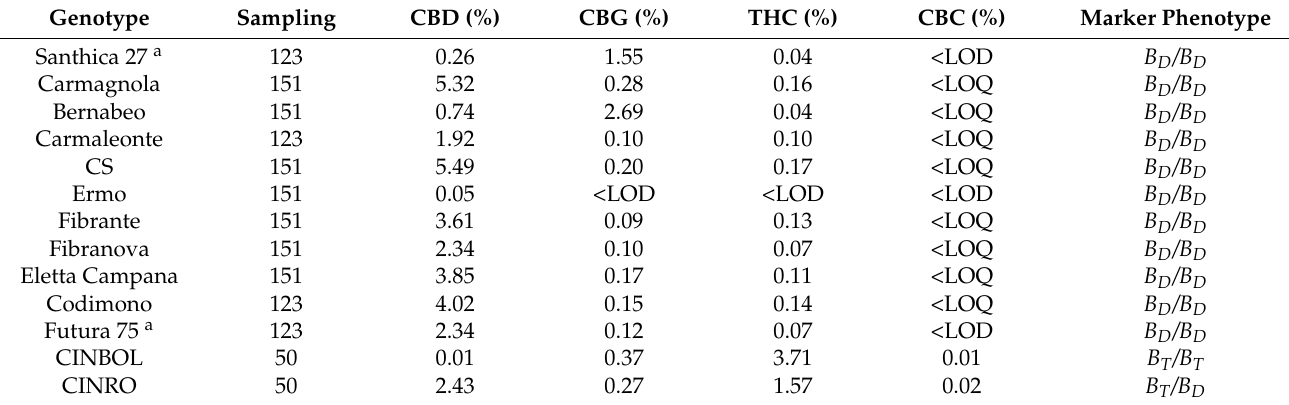
Table 1. Quantitative results of total cannabinoid analysis expressed as the mean of 3 replicates. LOD (limit of detection): 0.001%. LOQ (limit of quantification): 0.005%. Information regarding inflorescences sampling period is expressed as days after sowing for hemp varieties, as days from onset flowering for CINBOL and CINRO. Results of genotyping obtained using the marker B1080/B1192 are given for each genotype. B D and B T refer to the allelic status as determined by the marker [25]. Data are expressed as percent of total inflorescence dry